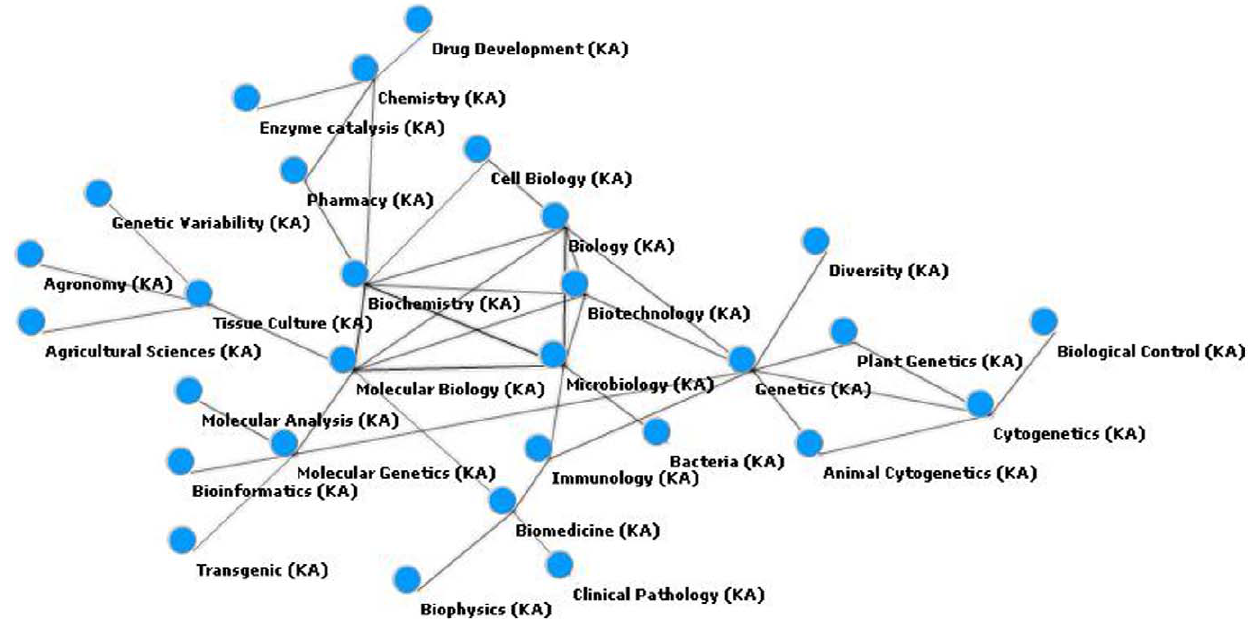
Figure 7. Expanded network graphic for the biotechnology instance.